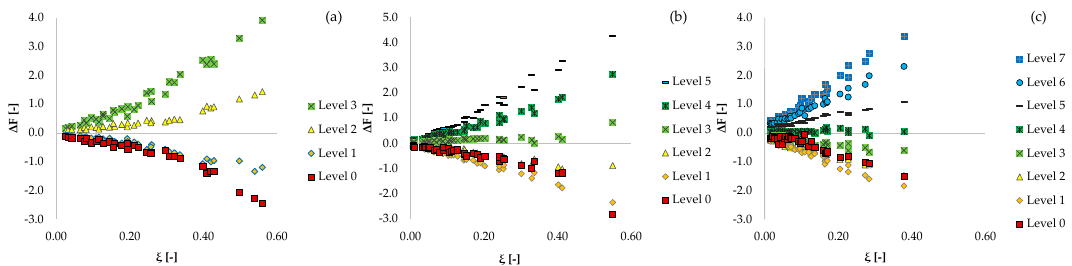
Figure 11. Relationship between relative error of shear force at the varying levels and the equivalent damping ratio for three-story ( a ), five-story ( b ), and seven-story ( c ) buildings. Figure 10 shows an almost linear correlation between the relative error of shear forces and the e ff ective damping. Passing through the origin, the relationship highlights the suitability of the uniform distribution for value of ξ near zero and the inadequacy to describe the seismic response of BI structures even for relatively low values of the e ff ective